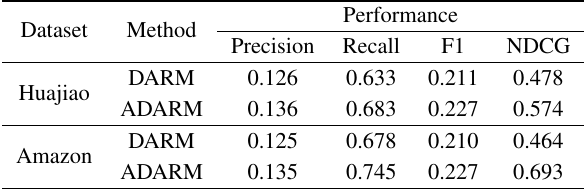
Table 4 Performance of DARM and ADARM for top 10